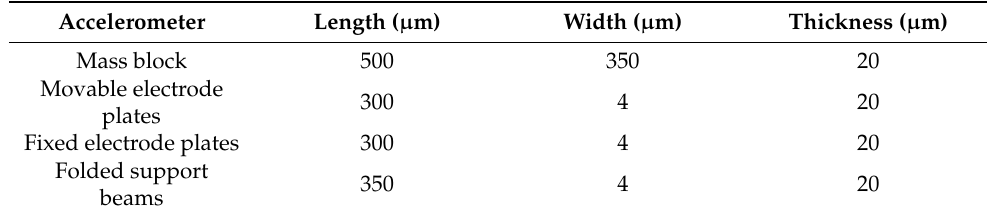
Table 1. The structural parameters for the capacitive micro-accelerometer